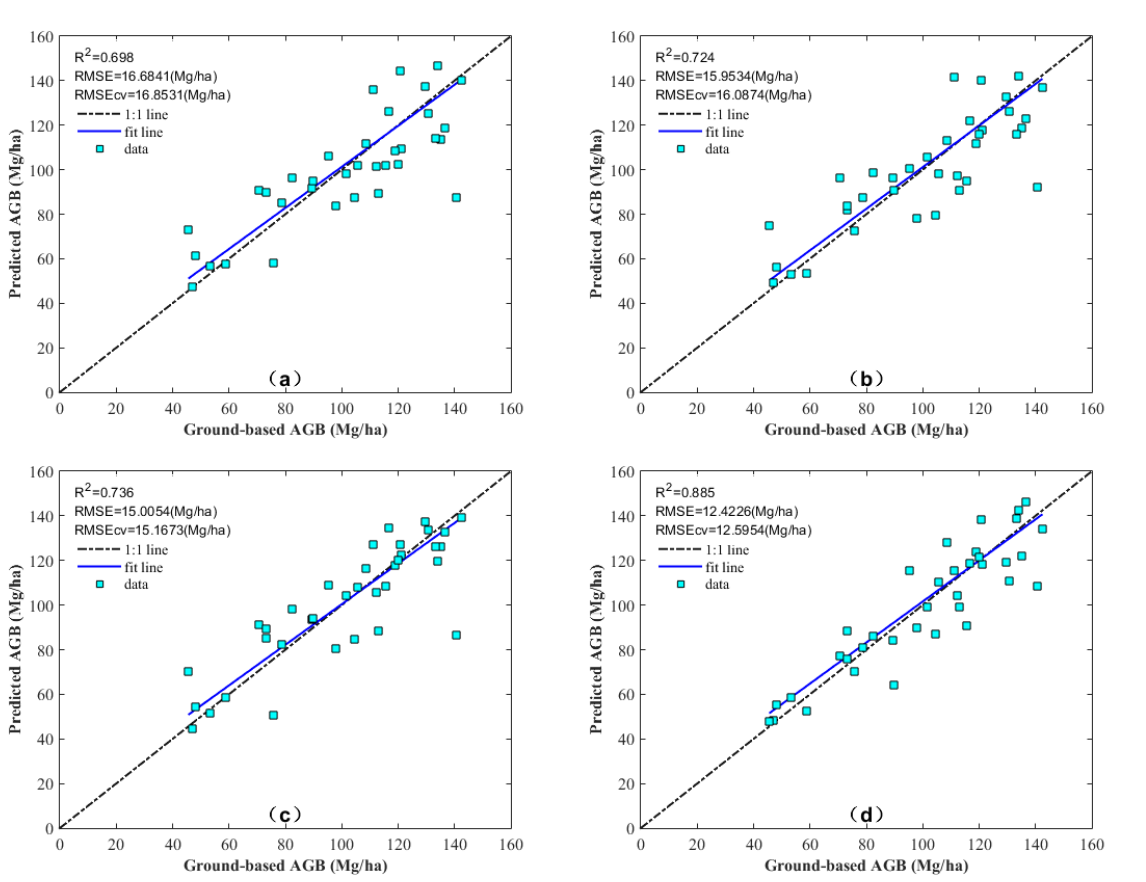
Figure 2. Ground-based AGB value (Mg/ha) versus predicted AGB value (Mg/ha) from the regression model using LiDAR feature metrics. (a) and (b) are the regression results using original LiDAR feature metrics by multiple stepwise regression (MS) model, (c) and (d) display the regression results using reconstructed LiDAR feature metrics by partial least square regression (PLS) model.